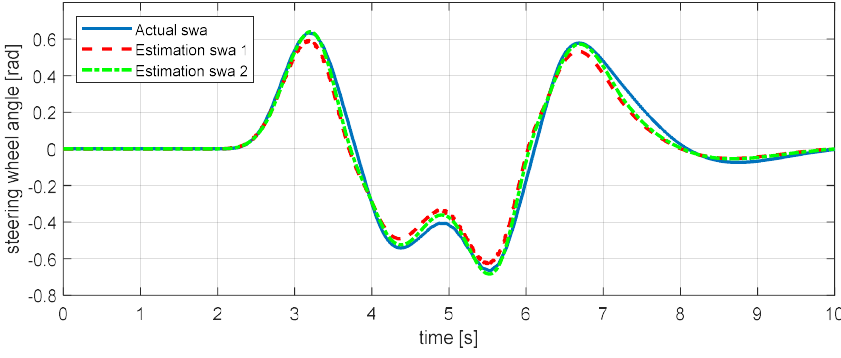
Figure 10. Estimation simulation result for the steering wheel angle.